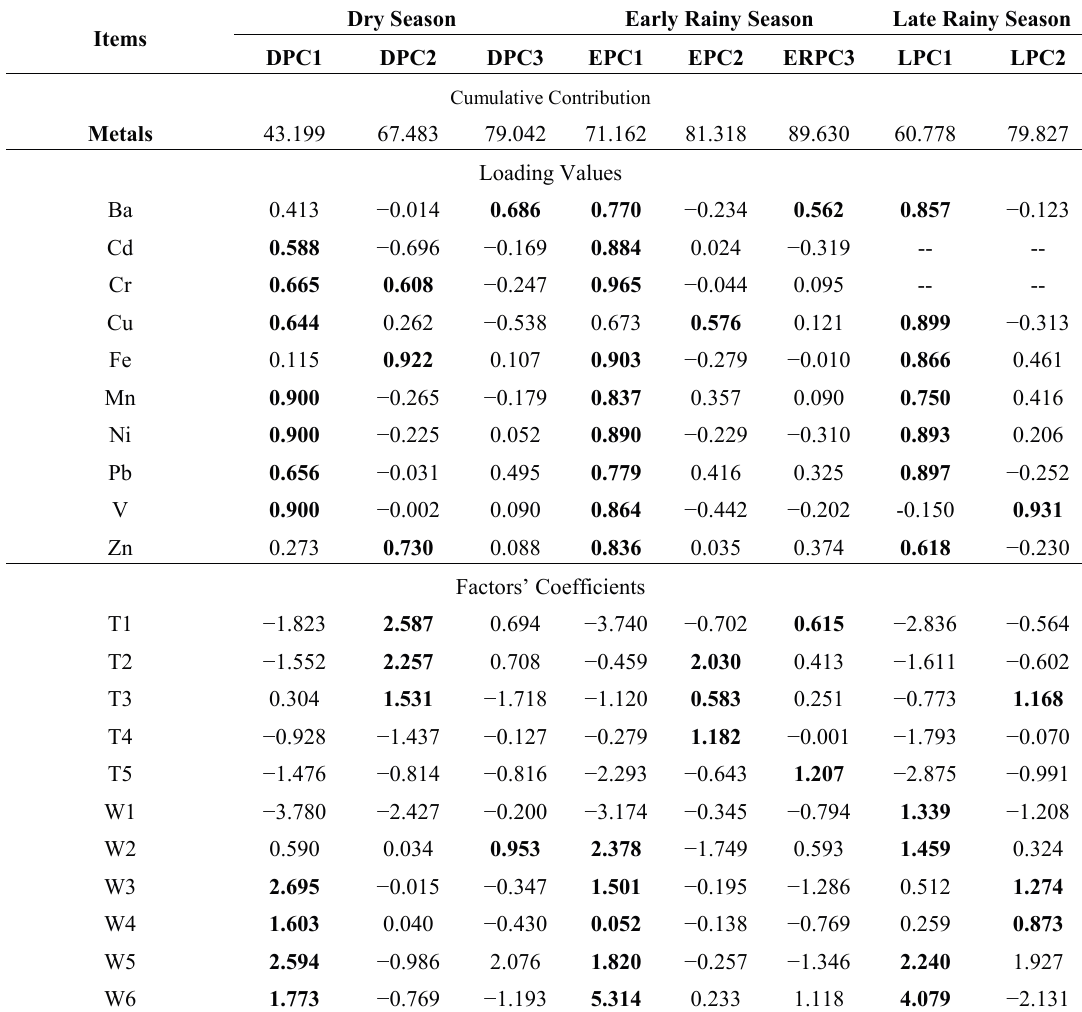
Table 4 . Cumulative contributions (%), loading values, and factor coefficients for the principal components for each